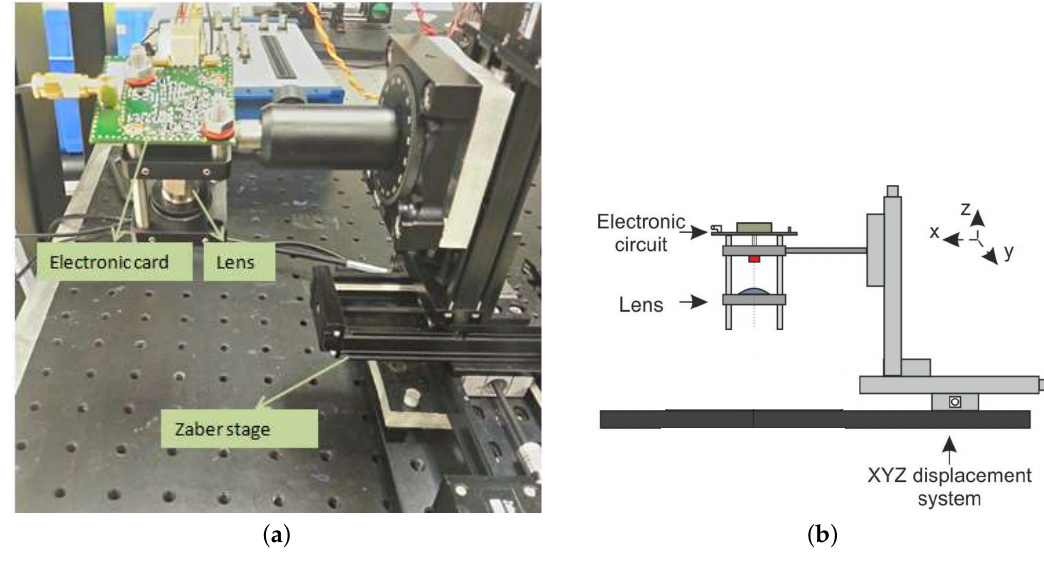
Figure 18. Optical setup. ( a ) Image of the optical setup with the described components; ( b ) Graphical layout of the